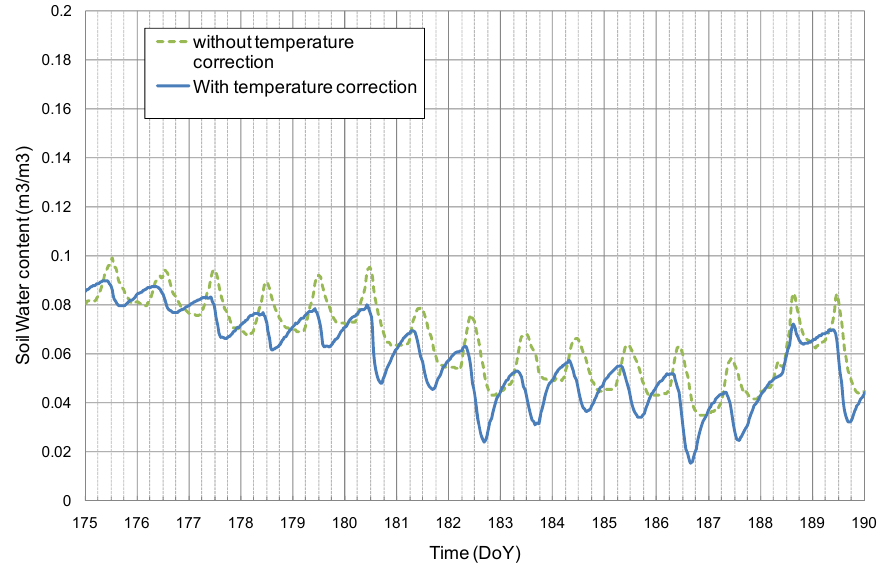
Figure 8. Soil water content measured by an EC-10 installed at a 2.5-cm depth. The probe calibration was done either with the unprocessed measurement (dotted line) or with the measurement corrected by the temperature effect (solid line). Vertical solid grids correspond at